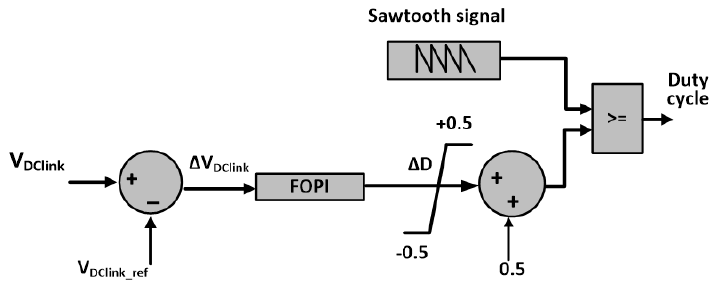
Figure 2. Proposed control system using FOPI.